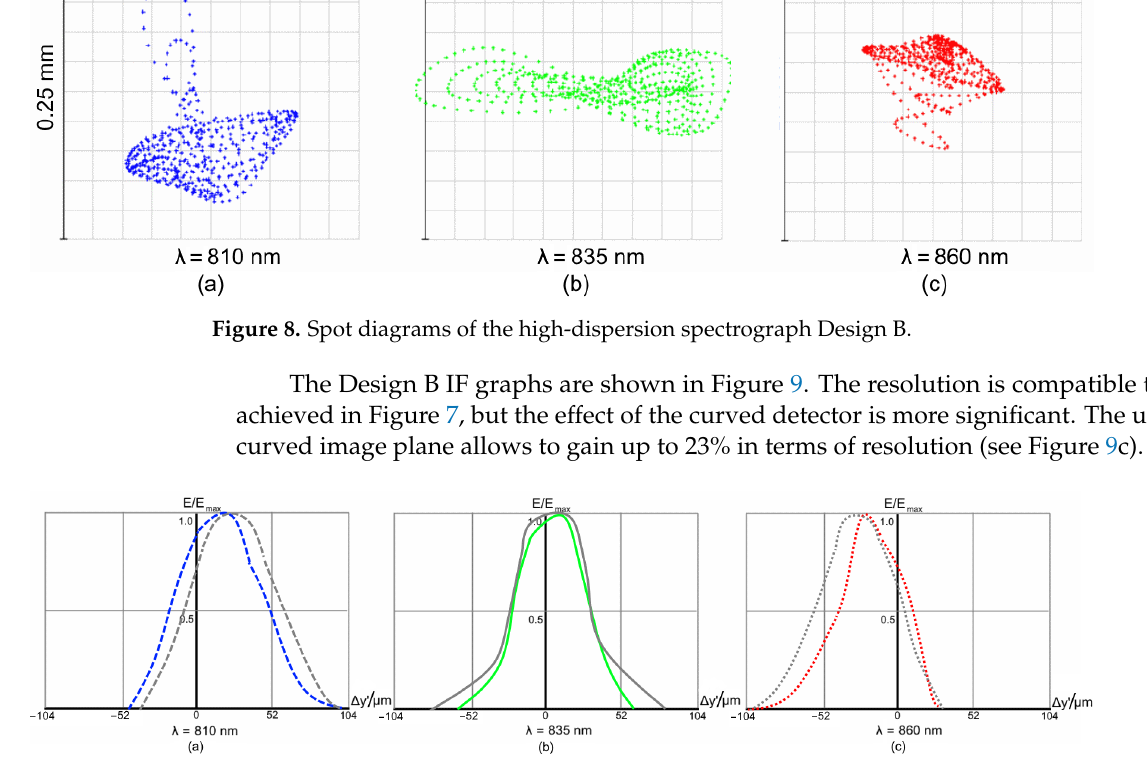
Figure 9. Instrument functions of the high-dispersion spectrograph Design B for a 50 µ m input fiber. The grey lines correspond to the design with flat detector.